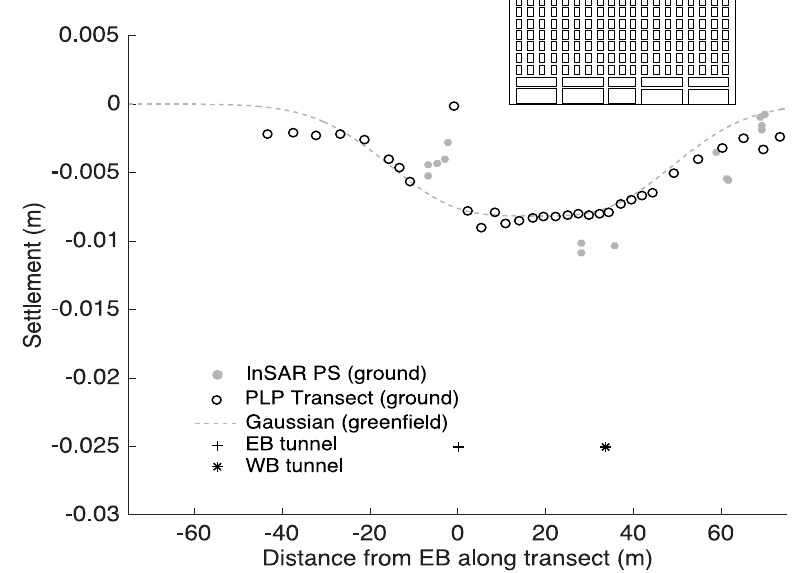
Figure 3. Example of ground- and MT-InSAR-based displacements at the ground level (adjacent to the building). The EB and WB tunnel markers indicate the centerline of the Eastbound and Westbound tunnels respectively.